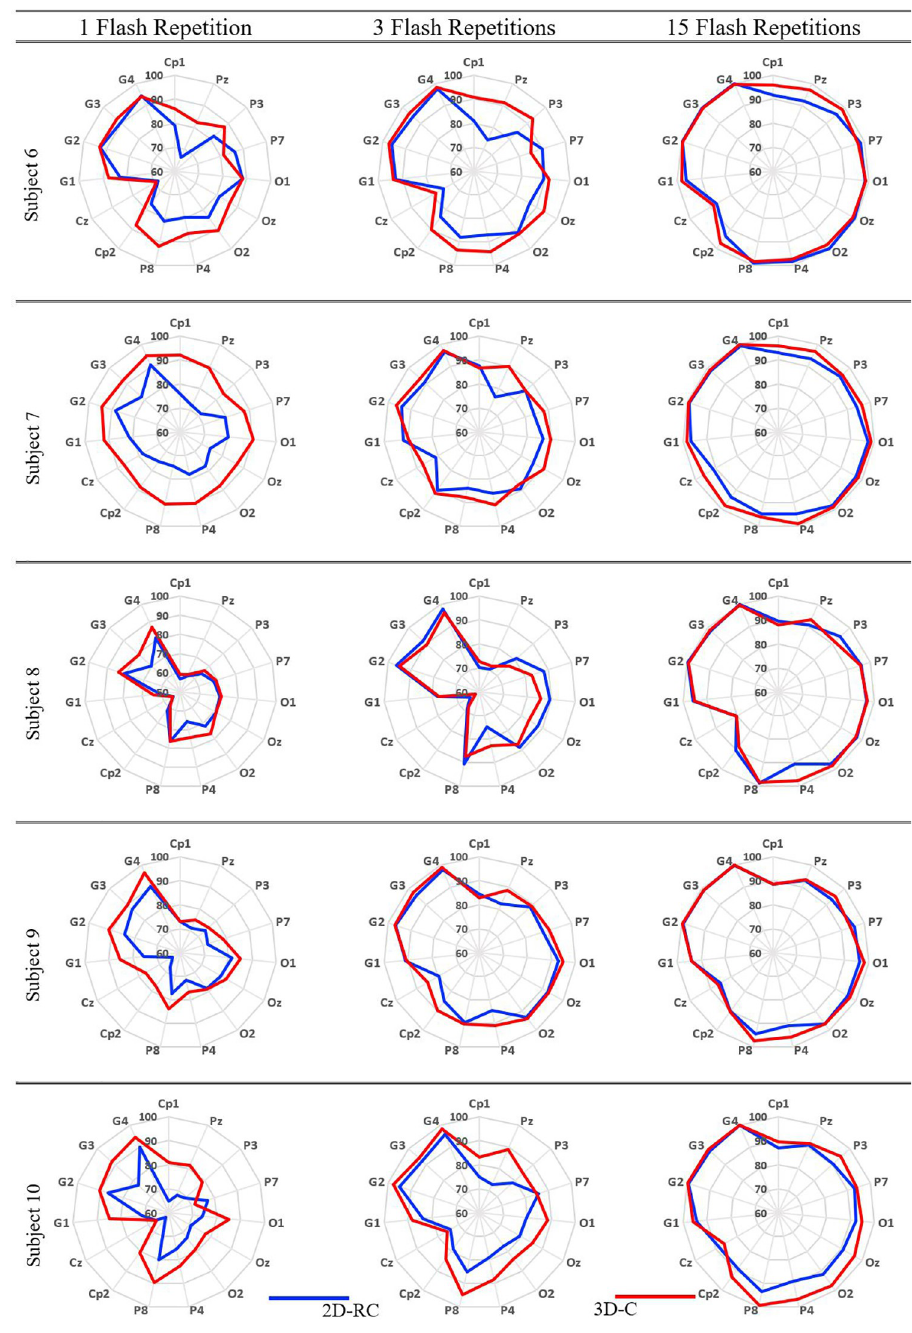
Fig 14. Different repetitions result for subjects